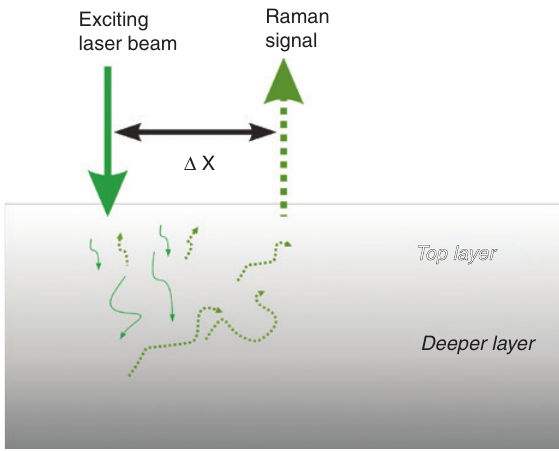
Figure 11: Principle of spatially offset Raman spectroscopy. Raman scattered light from deeper layers can be collected in a distance Δ x from the spot of illumination. The larger the distance, the higher the ratio of signal from deeper layers, but also the smaller the signal intensity. Δ x = 0 is equal to the signal collection geometry of conventional Raman